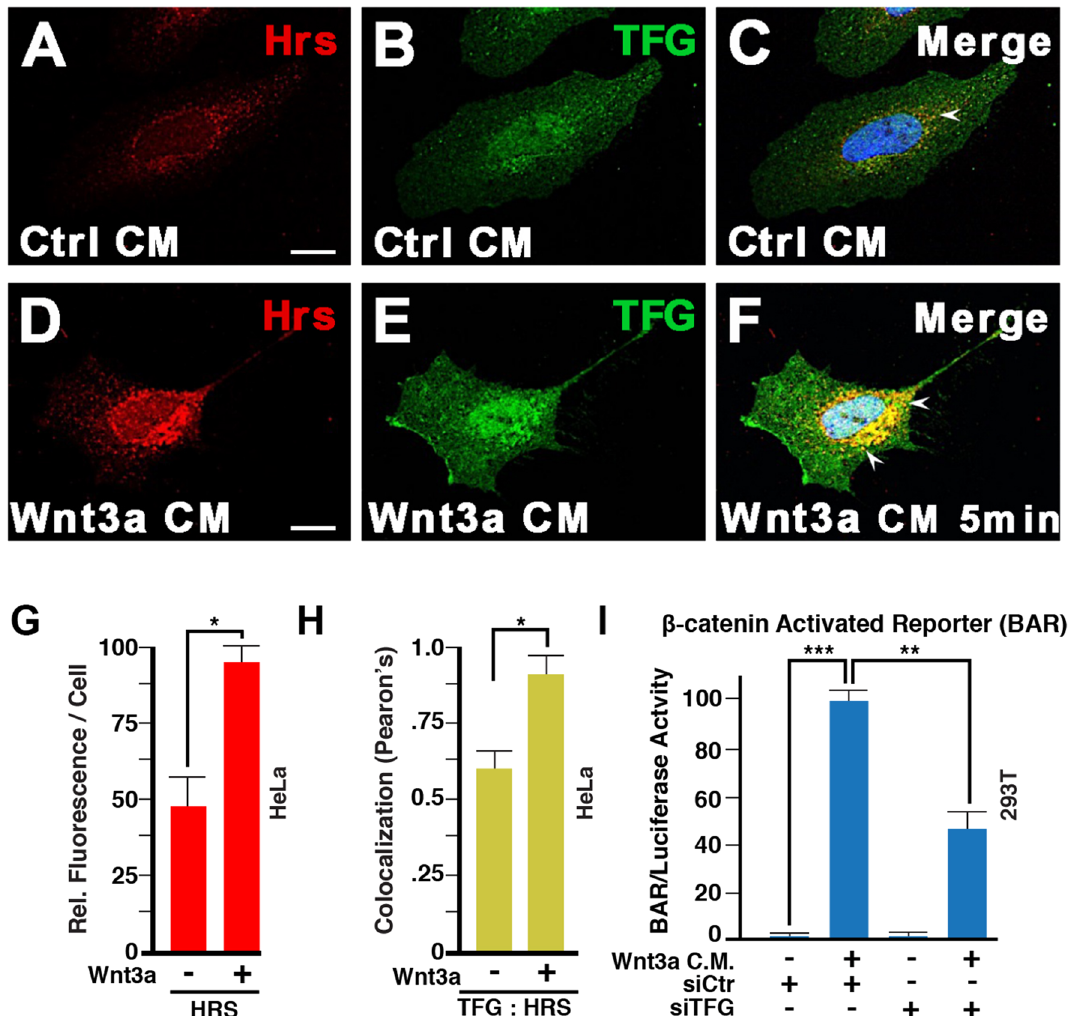
Figure 3. TFG co-localizes with the ESCRT-0 protein Hrs/Hgs and is required for Wnt signaling. ( A – F ) Immunostaining on HeLa cells for endogenous Hrs and TFG. Weak co-localization was observed in absence of Wnt signaling (arrow in panel C ). However, 5 min of Wnt3a treatment was sufficient to strikingly increase the number of endocytic vesicles containing both Hrs and TFG (arrows). Scale bar 10 µm. ( G ) Wnt signaling (5 min) increased the number of Hrs positive vesicles quantified as fluorescence per cell; this supports the rapid formation of MVBs in Wnt signaling. ( H ) Wnt3a increased co-localization of TFG puncta with the Hrs MVB marker by Pearson’s correlation coefficient. ( I ) TFG knock-down by siRNA reduced Wnt signaling, as assessed by β-catenin Activated Reporter (BAR/Renilla) Luciferase assay in HEK293T